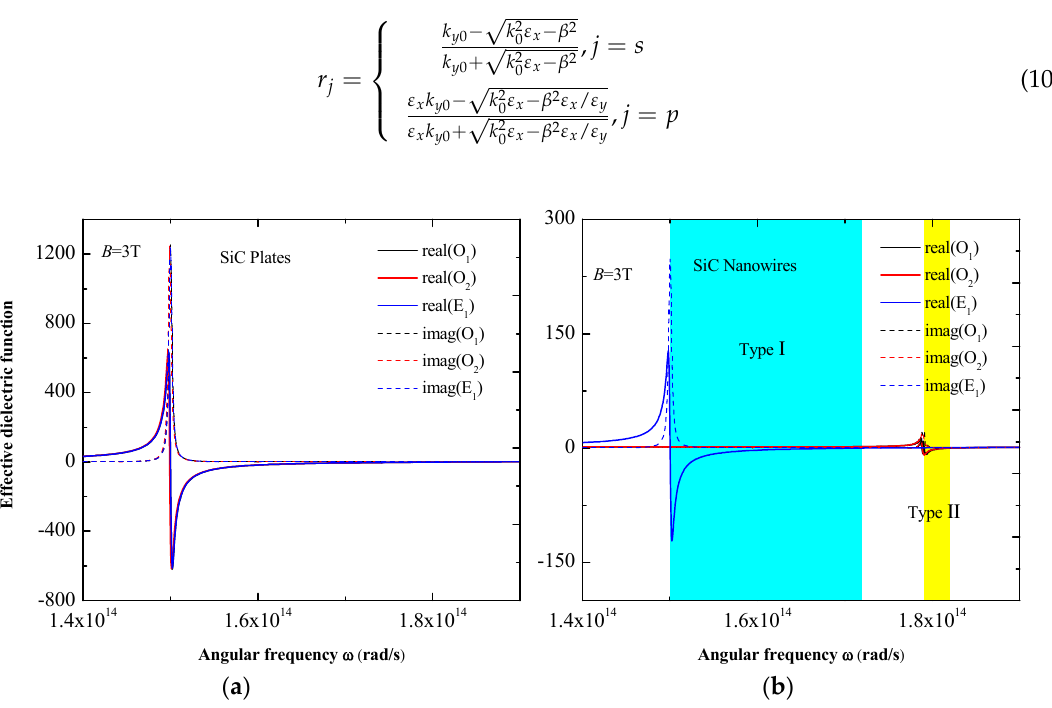
Figure 3. The effective dielectric function for ( a ) SiC plates and ( b ) SiC nanowires at f = 0.2.